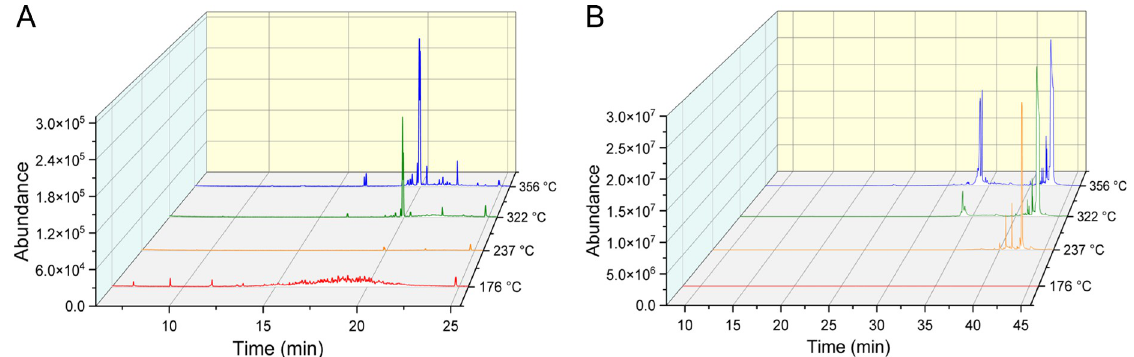
Fig 6. TIC of tube furnace pyrolysis emissions collected at 176, 234, 322, and 356˚C. TIC of tube furnace pyrolysis emissions collected at 176, 234, 322, and 356˚C obtained from (A) a polar Rtx-VMS fused silica separation column and (B) a non-polar J&W Scientific DB-5MS separation